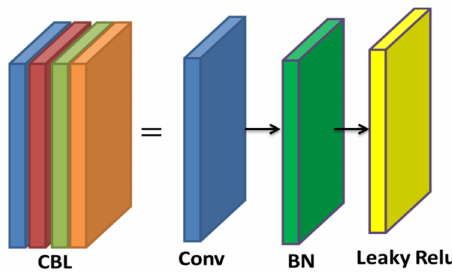
Figure 7. Architecture of the CBL module. Figure 8 represents the visualization of the CSP1_X and CSP3_X modules’ output. Here, each convolution layer extracted the significant features in the CSP modules. There- fore, the convolution filters retained the image features at each section of the input image.